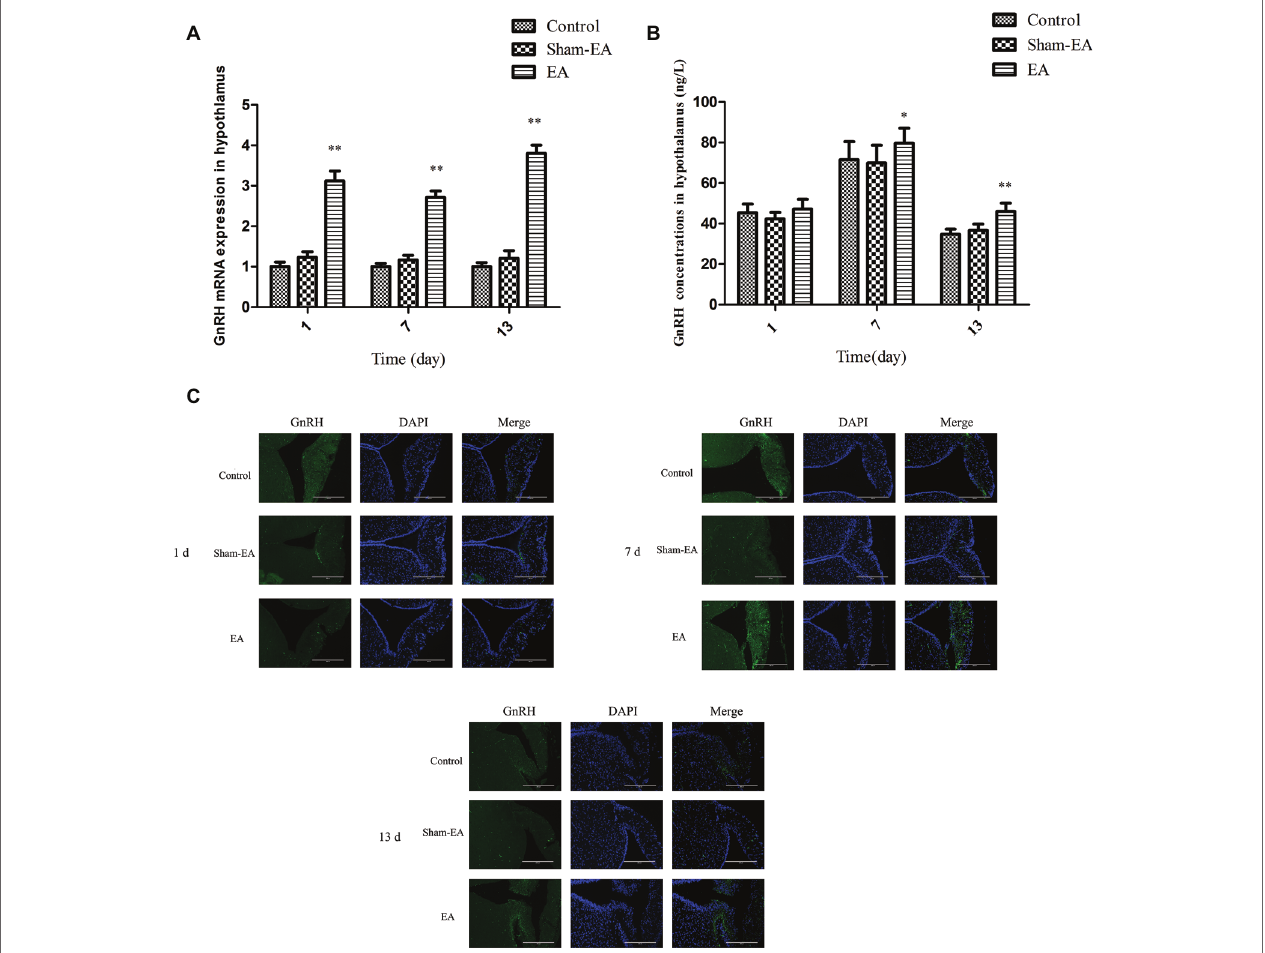
FIGURE 2 | EA simulation facilitated GnRH expression in hypothalamus in female rats. (A) The GnRH mRNA level in hypothalamus. (B) GnRH concentrations in hypothalamus. (C) Dual immunofluorescence showing the expression of GnRH (green) and the neuronal nuclei (blue) in ME in hypothalamus. Scale bars represent 200 μm. Data are presented as means ± SD, * indicates the change of the GnRH levels are different between EA-treated rats and Control rats, * p < 0.05, ** p < 0.01.